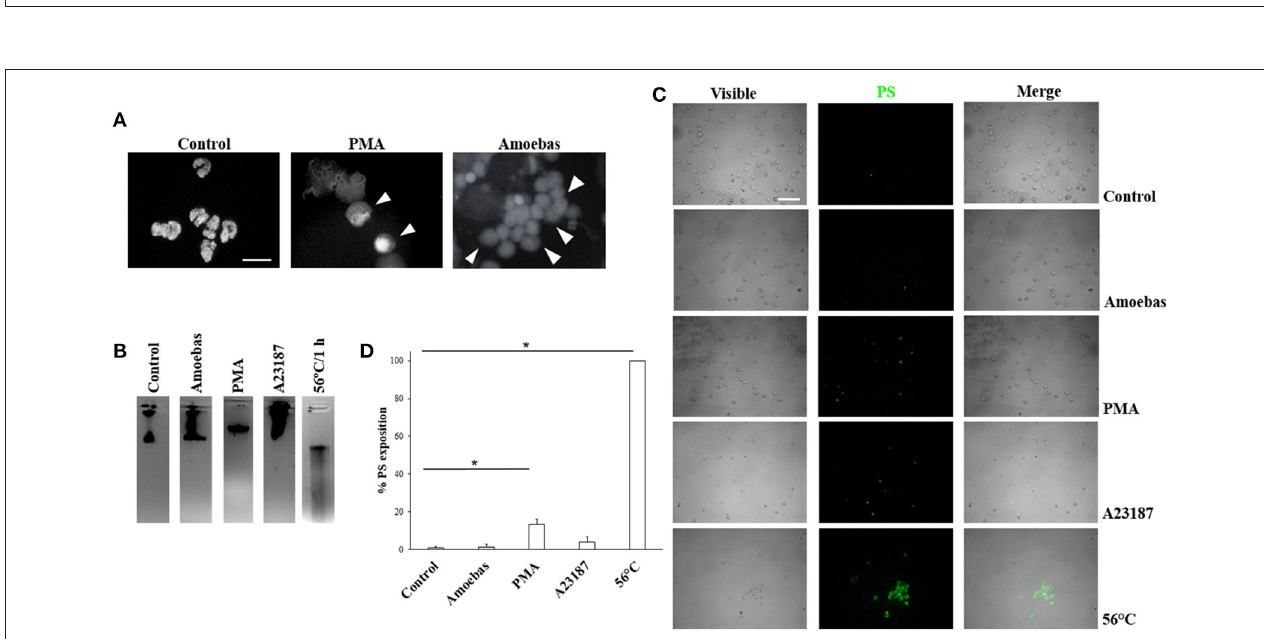
FIGURE 3 | Trophozoites induces NETosis without evidence of apoptosis or necrosis. (A) Neutrophils were incubated with 20nM PMA or trophozoites (ratio 20:1). After 4h of incubation, cells were fixed and stained with DAPI. Decondensed chromatin is shown (arrowheads). Images were taken at 100x magnification. Scale bar 10 µ m. (B) DNA from neutrophils (1 × 10 6 ) treated for 1h with trophozoites (5 × 10 4 ) or 20nM PMA or 10 µ M A23187 or heat (50 ◦ C) were extracted and run in 1.8% agarose gel and the bands visualized by staining with ethidium bromide. (C) Phosphatidylserine (PS) exposition was assessed by fluorescence microscopy using FITC-annexin V. (D) Percentage of cells positive to PS was determined in a total of 300 stained neutrophils. Values are means ± SD of three independent experiments. * p < 0.001.